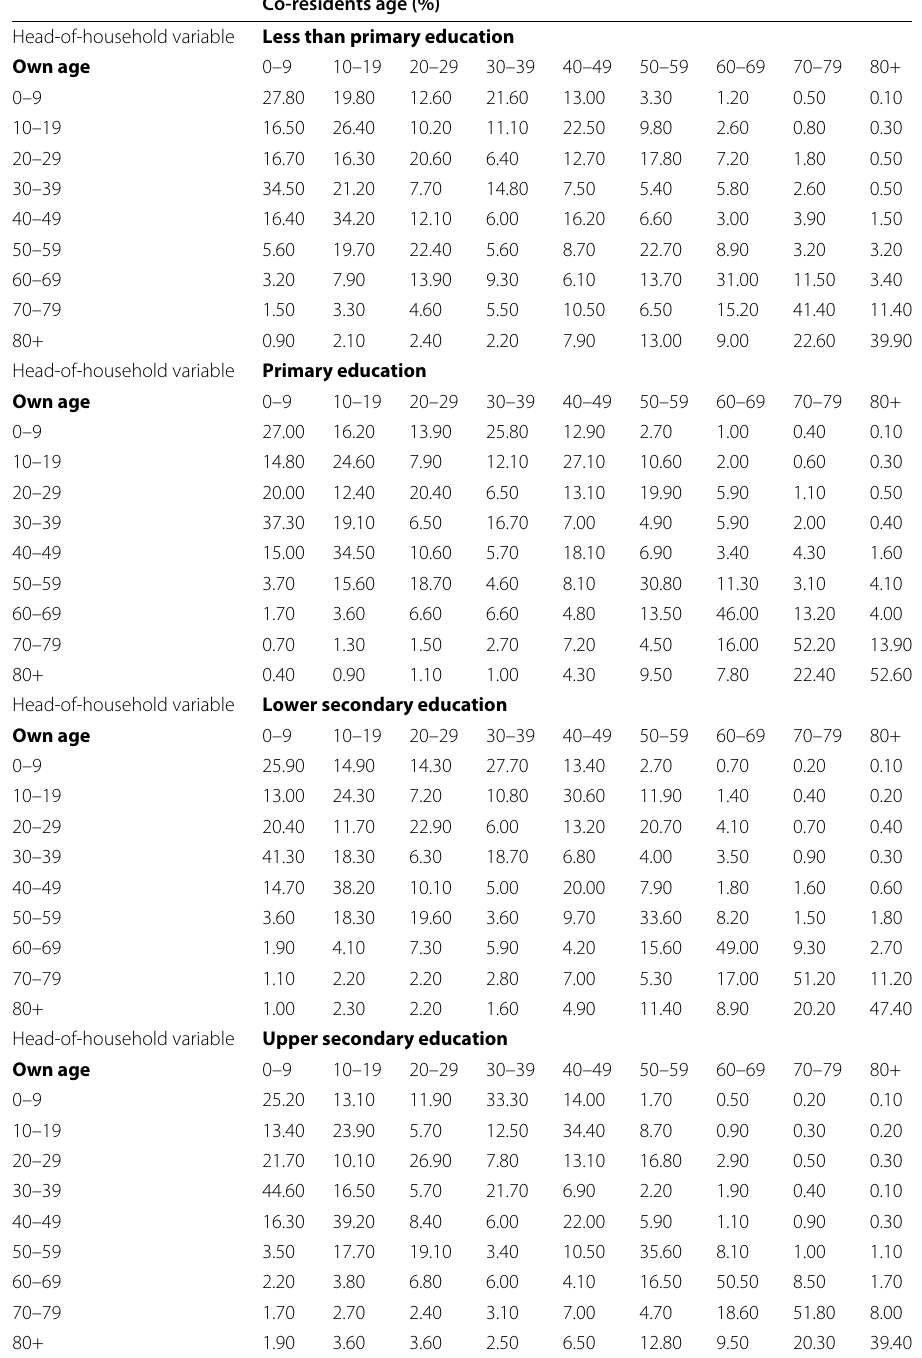
Table 8 Share of co-residents members by age and head-of-household education level Co-residents age (%) Head-of-household variable Less than primary education